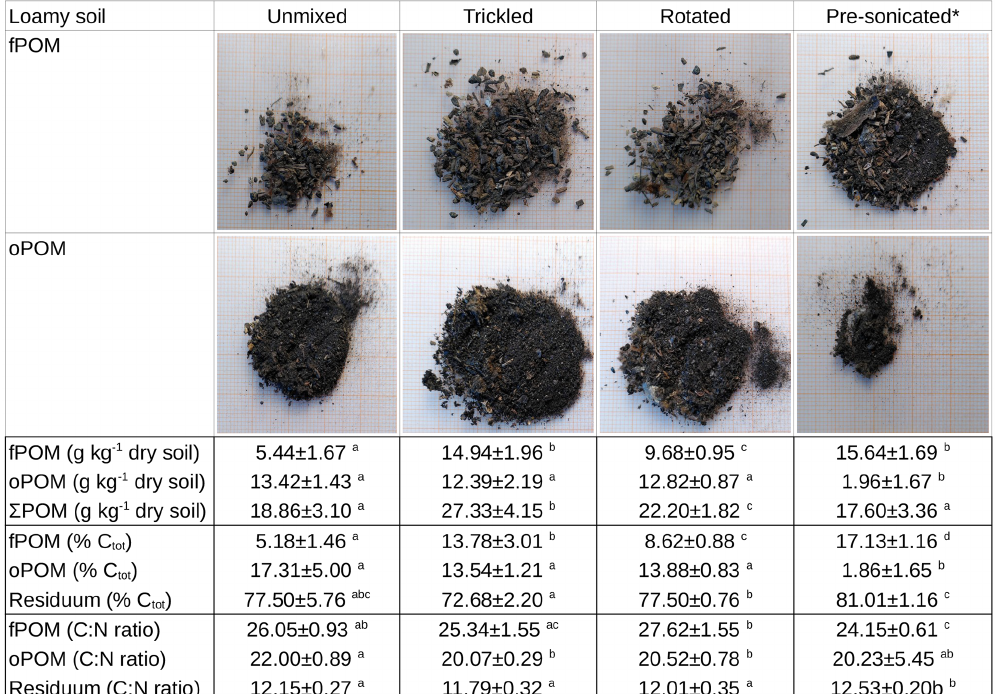
Table 1. Soil organic matter (SOM) release of a loamy topsoil after different approaches for merging sample and dense medium. fPOM refers to the free particulate organic matter floating after application of 0JmL − 1 , oPOM to the occluded particulate organic matter released after application of 50JmL − 1 ( ∗ in case of the treatment with minimum ultrasonication of 15 and 35JmL − 1 , respectively). C tot refers to the percentage of total SOC contained in each fraction. ± refers to the standard deviation. Small superscripts are Tukey’s characters ( a, b, c, d ) and mark significant differences between the treatments of the loamy soil ( p < 0 .